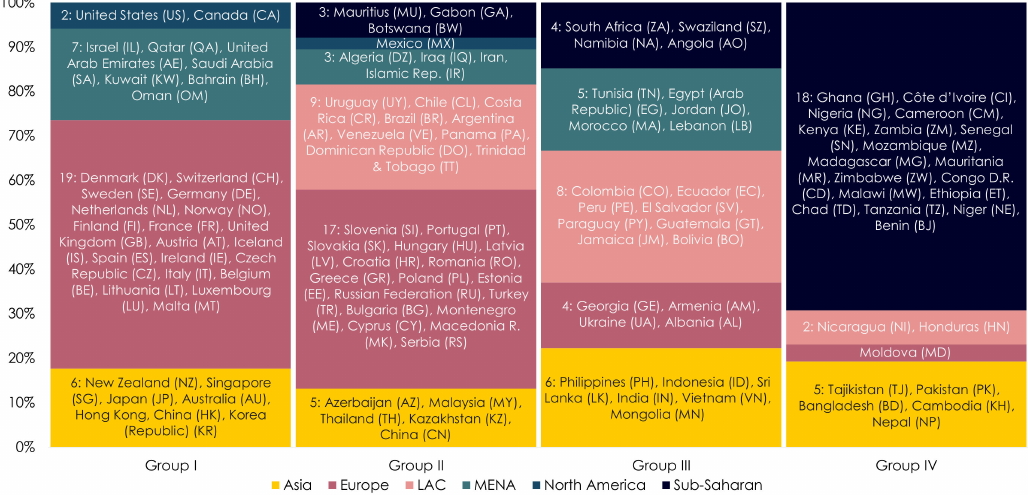
Figure 2. Distribution of the 125 countries of the ETI (Energy Trilemma Index) 2017 by regions and GDP groups per capita. Notes: Regions are divided (greatest to least presence) into Europe with 41 countries (32.8%), Sub-Saharan 25 (29%), Asia 22 (17.6%), LAC 19 (15.2%), MENA 15 (12%) and North-America 3 (2.4%). The GDP groups are divided as: Group-I has 34 countries (27.2%), Group-II has 38 (30.4%), Group-III has 27 (21.6%), and Group-IV has 26 (20.8%). Source: Created by authors using data from [12].